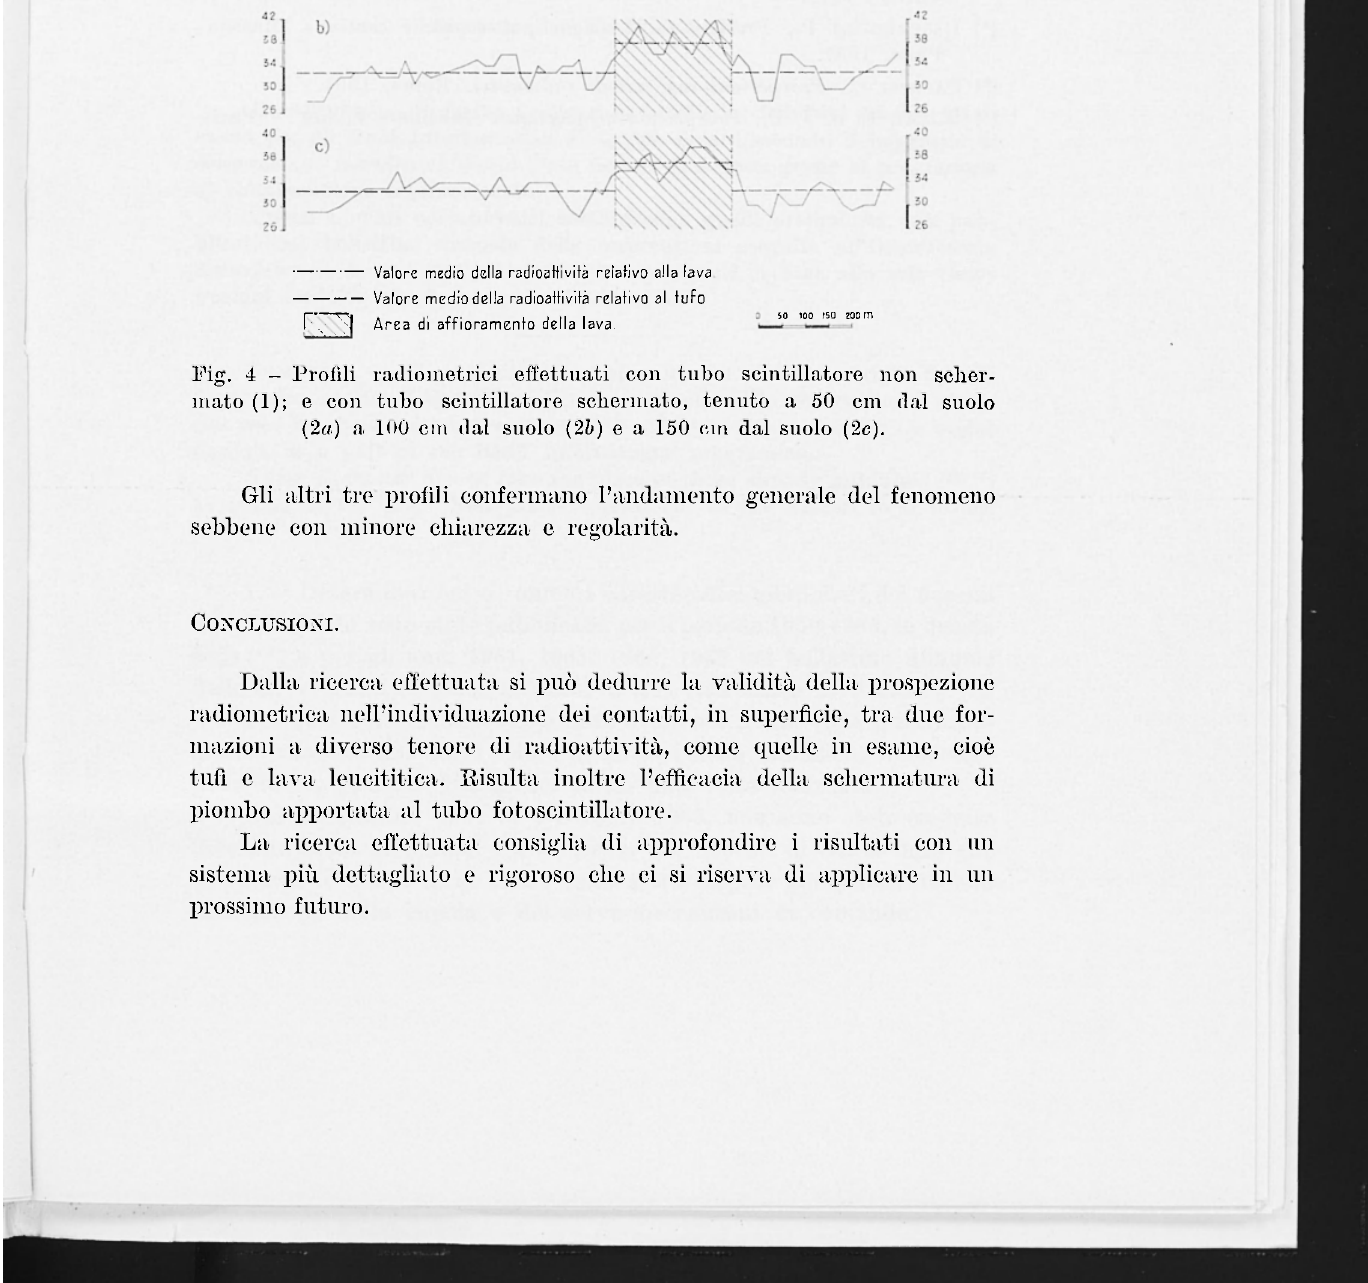
Fig. 4 - Profili radiometrici effettuati con tubo scintillatore non